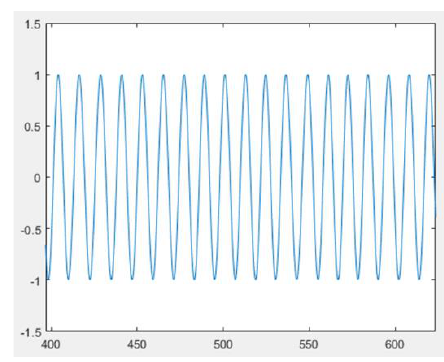
Fig. 9. Final filtered